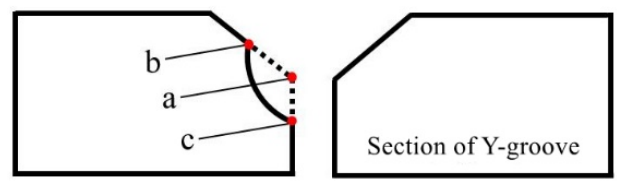
Figure 5. Defects on the surface of the weldment.